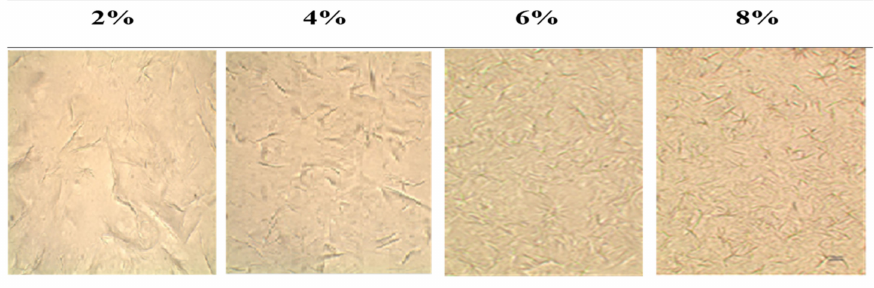
Figure 1. The structure of peanut oil oleogels with yellow beeswax at concentrations: 2, 4, 6 and 8% in the microscopic image at 600 ×